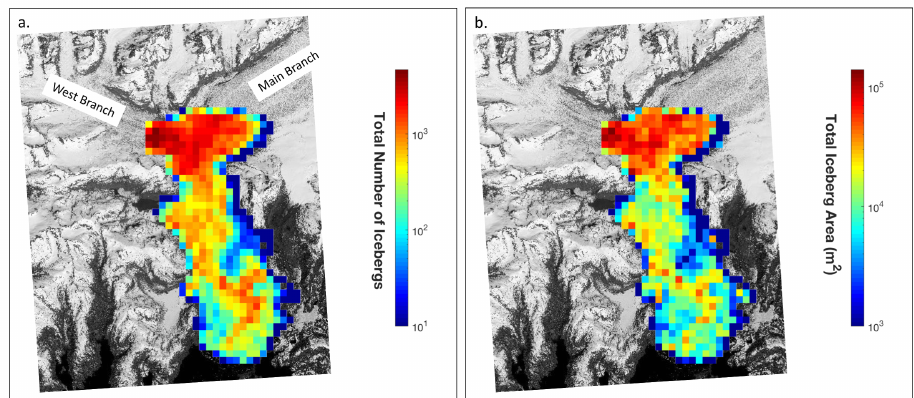
Figure 4. Cumulative iceberg population density and area map. Each grid cell represents a 500m × 500m square. The scenes from 13 March, 6a May, 10a June, 12a July, and 19 November were overlain to obtain the total number and area of icebergs inside each grid cell. Data are overlain on a satellite image of the fjord taken by WorldView 1 on 10 June 2013 (© 2013 Digital Globe, Inc.). (a) Number of icebergs in each grid cell; (b) area of icebergs inside each grid